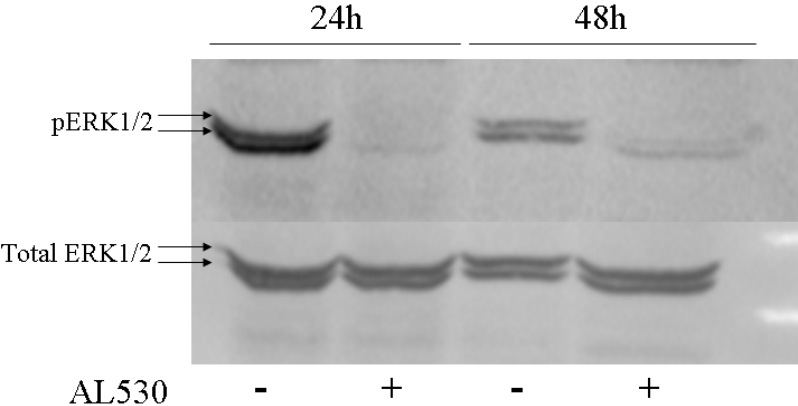
Figure 3. Study of Erk1,2 phosphorylation inhibition in CAL33 cells daily treated with AL530 (25 µM) for 24 to 48 h. At the indicated times in the figure, cells were harvested, lysed (RIPA buffer), an equal amount of protein was separated (12.5% SDS PAGE gel), blotted (PVDF membrane) and coated with antibody of interest.